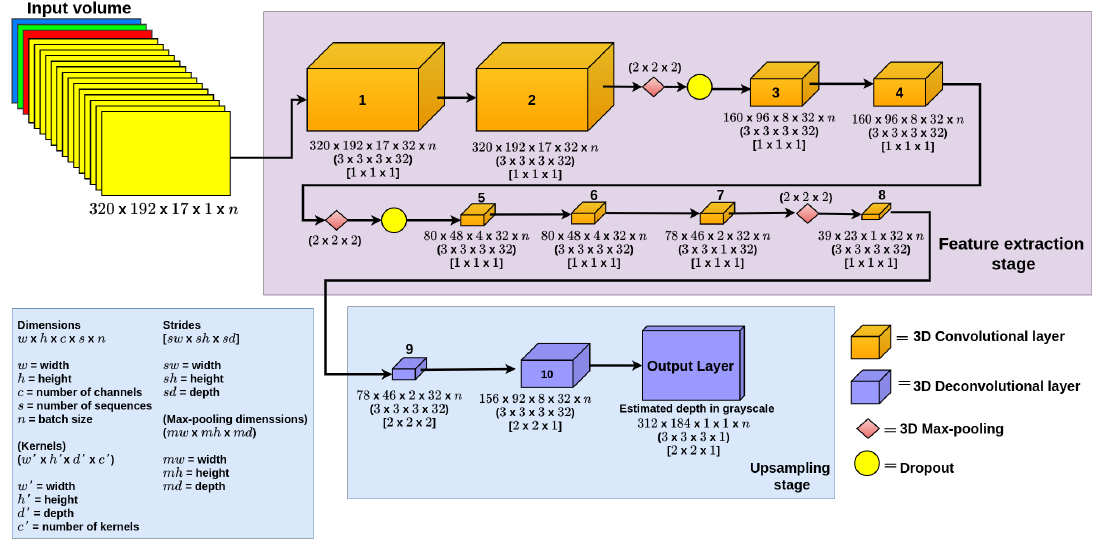
Figure 8. 3D CNN-UP.